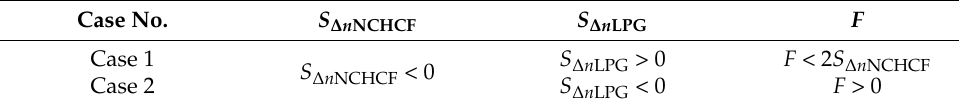
Table 1. Description of different cases of Equation